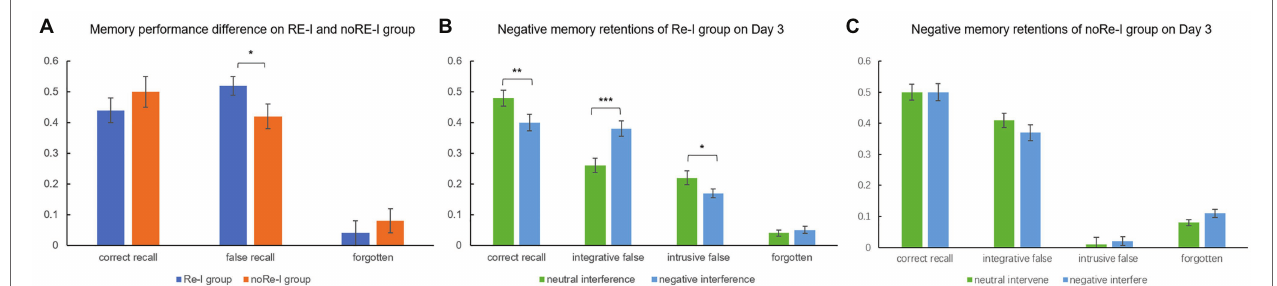
FIGURE 4 | Negative memory performance among two groups and different memory outcomes under neutral and negative interference (Experiment 2). (A) The replication of Experiment 1, in which the Re-I group showed higher false memory; (B) in the Re-I group, for original negative memories, negative interference materials produce lower correct recall and higher integrative false recall, while neutral interference materials produced higher unabridged invasion (intrusive false recall) to the original memory; (C) the noRe-I group did not show the valence related effect for interfering outcomes. The error bar in the figure represents the standard error, * represents p < 0.05, ** represents p < 0.01, and *** represents p <